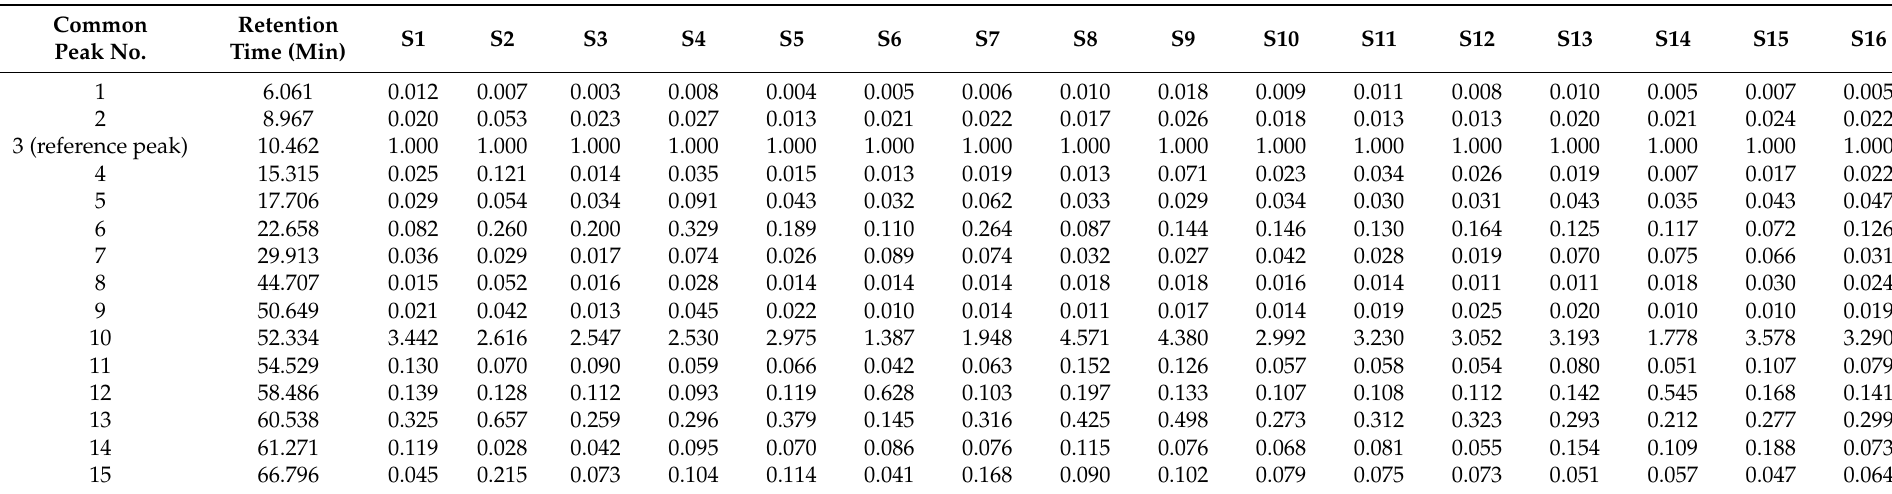
Table 3. The quantification of the common peak area of Echinacea pupurea (L.) Moench 15 × 16-order matrix (peak 3 is the control